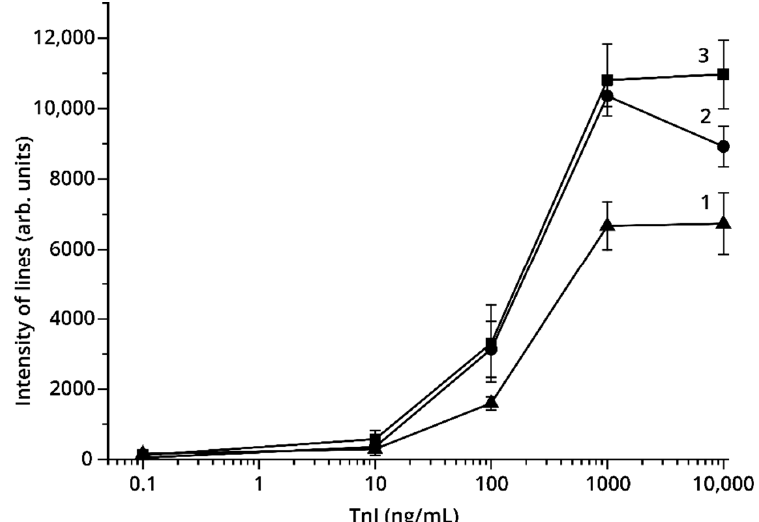
Figure 5. LFIA of TnI: concentration dependences for analytical zone intensity (arb. units) using different fiberglass membranes: 1—Millipore GFDx203000; 2—Ahlstrom-Munksjö 8951; 3—Advanced Microdevices PT-R7 (Variant No. 2 of the test system).